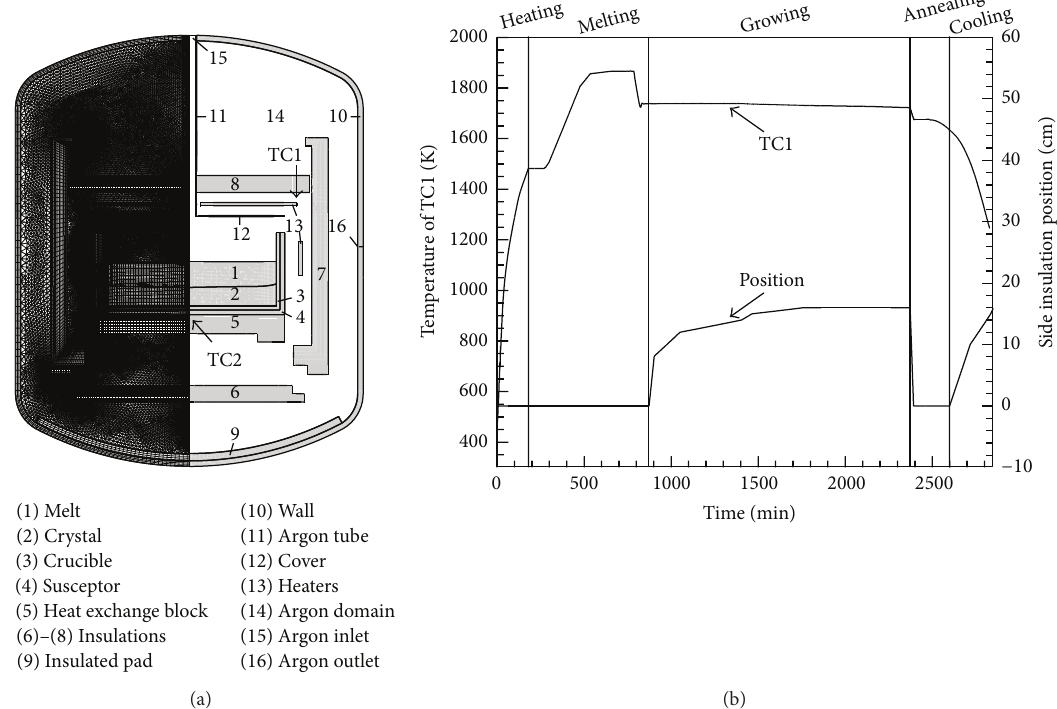
Figure 1: Model of an industrial-size DS furnace: (a) configurations and computational grids; (b) process control